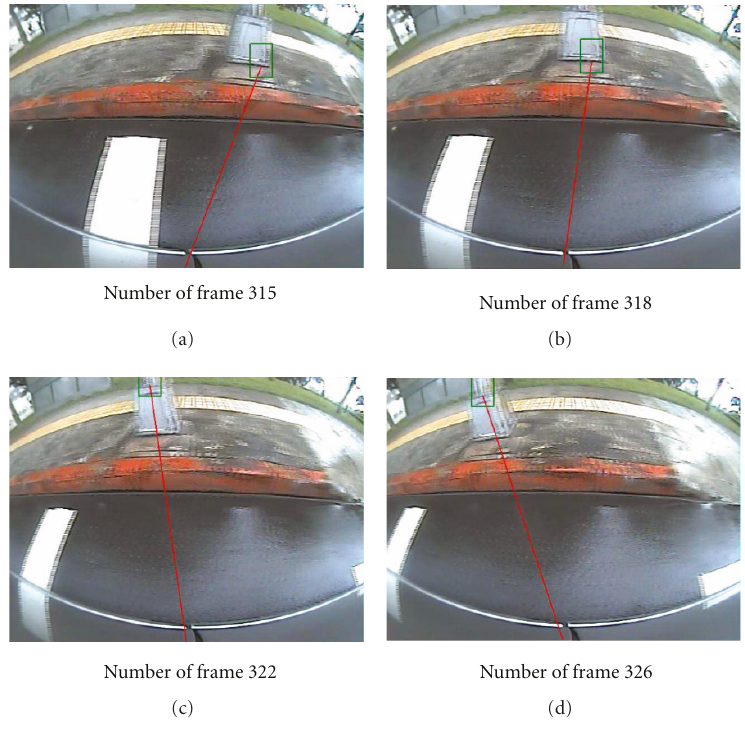
Figure 23: Results of obstacle tracking in Scenery 1.